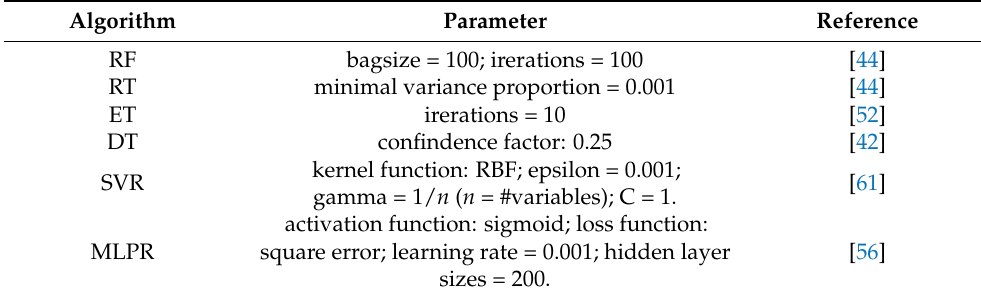
Table 3. Parameter setting of five intelligent algorithms.